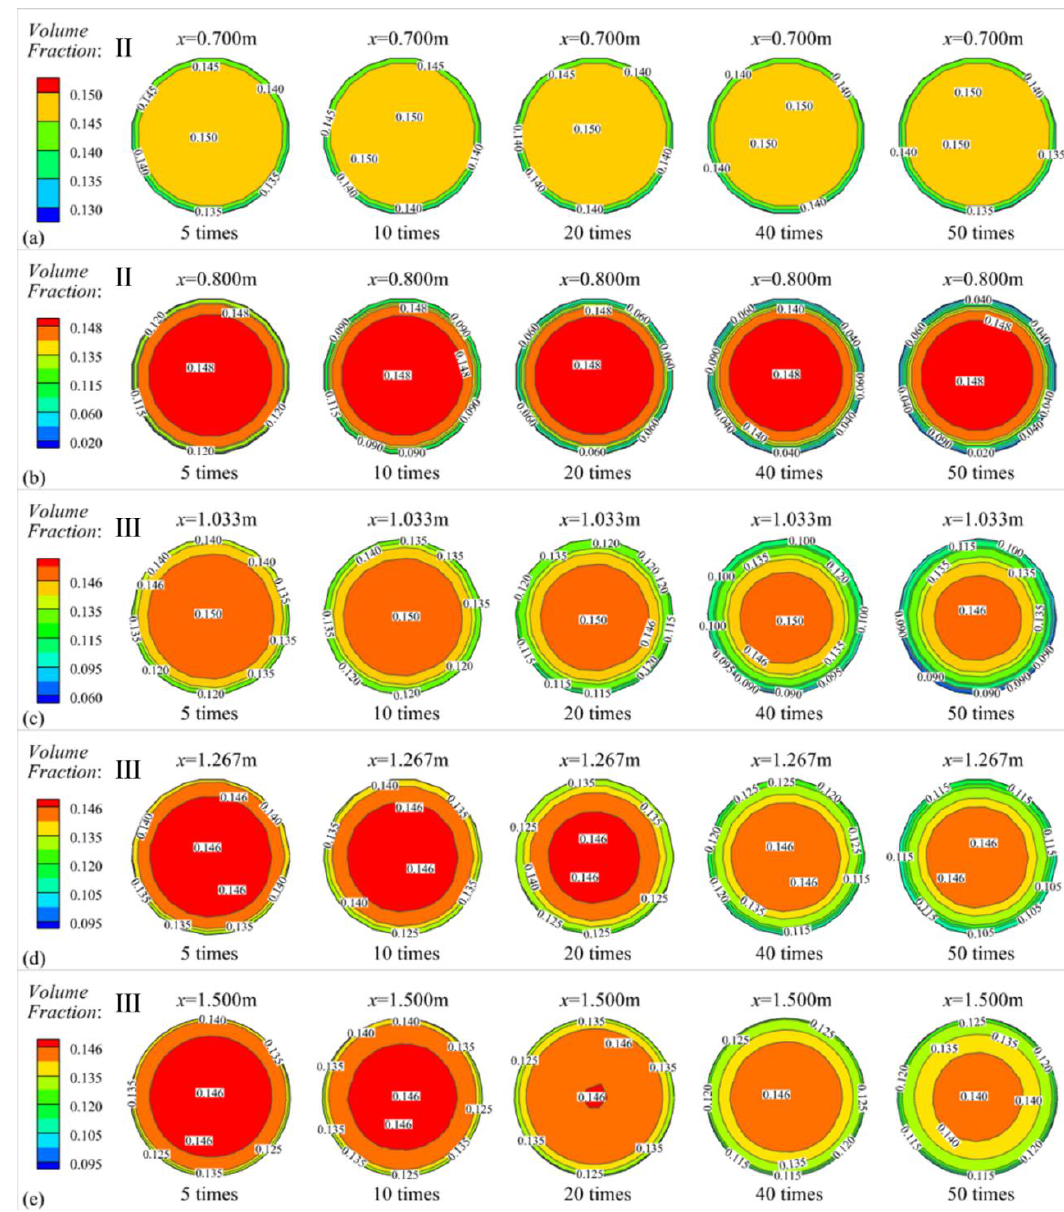
Figure 12. Distribution of IVF for fivelocal large heat flux multiples (5, 10, 20, 40, 50 times) at different x cross-sections ( a ) 0.7 m, ( b ) 0.8 m, ( c ) 1.033 m, ( d ) 1.267 m, ( e ) 1.5 m.